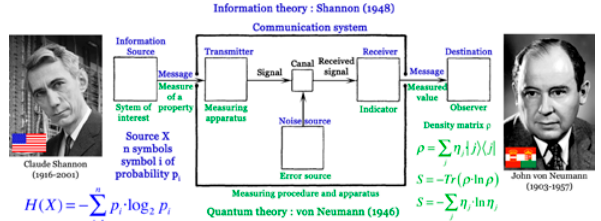
Figure 6. Similarity in logical structure between information theo- ry and quantum theory meaning that information content for the mind should correspond to entropy for the body. Adapted from J. Rothstein (1951).